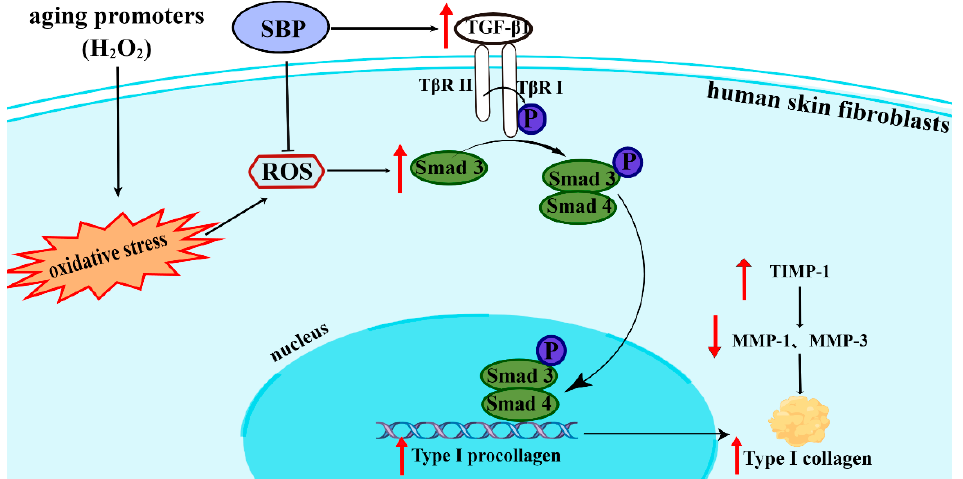
Figure 7. A possible mechanism by which SBP has anti-aging effects on the skin. SBP enhances Col I accumulation by modulating the TGF- β 1/Smads pathway in HSFs and inhibits collagen degradation by regulating the levels of MMP-1, -3, and TIMP-1 (diagram was drawn using Figdraw).